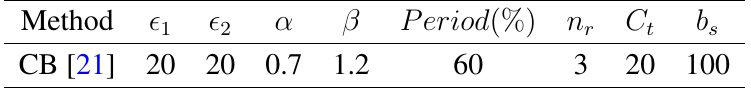
Table 4. Parameters for the experiment using both